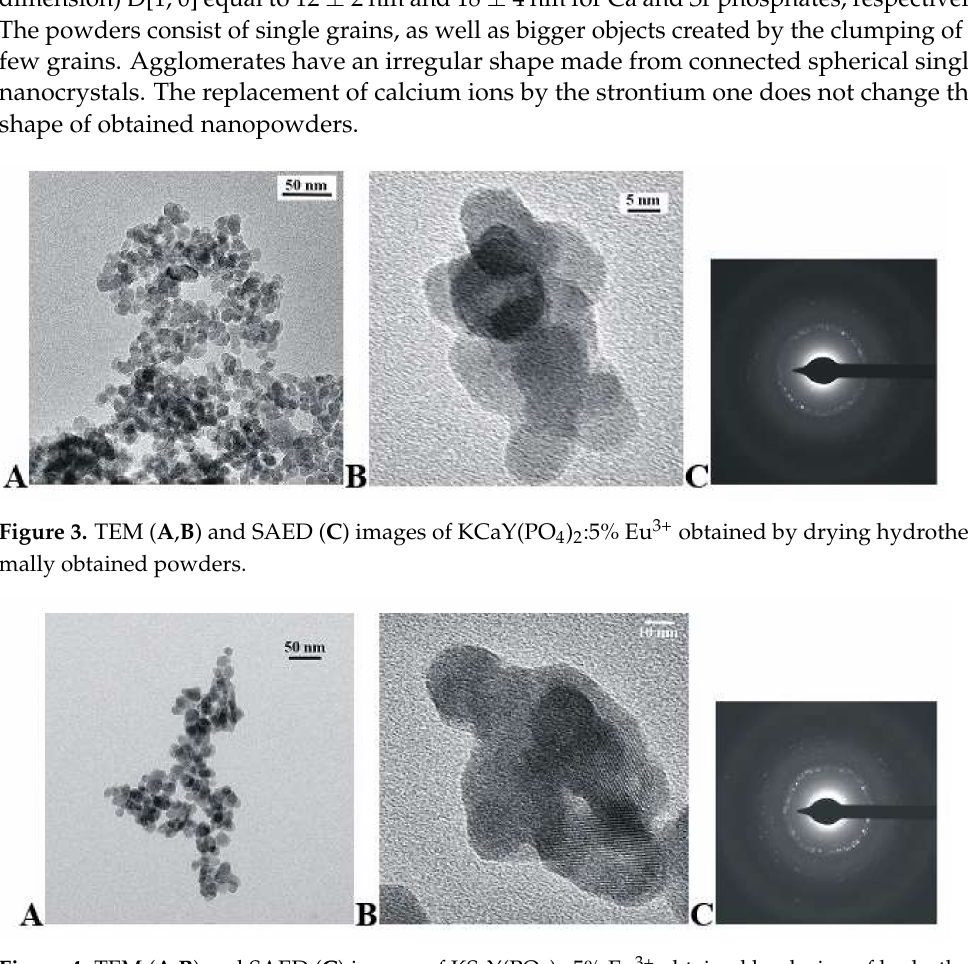
Figure 4. TEM ( A , B ) and SAED ( C ) images of KSrY(PO 4 ) 2 :5% Eu 3+ obtained by drying of hydrother- mally obtained